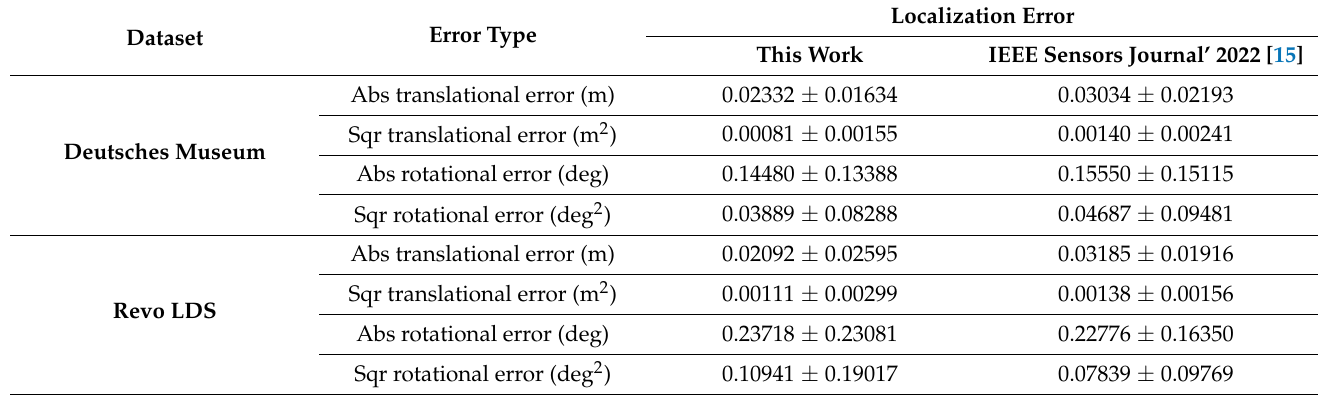
Table 1. Comparison of the localization error between the adopted NLO-CSM and the RIA-CSM.